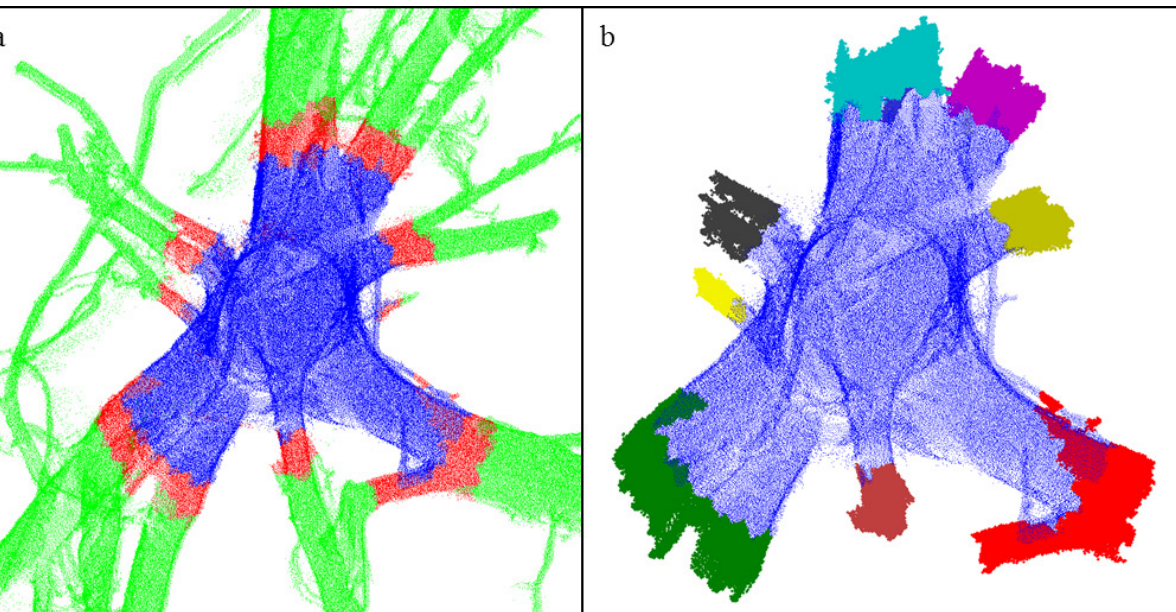
Figure 6. Determination of bases of the roots originating from the stump: ( a ) The layer B (red) between the stump (blue) and the rest of the roots (green) forms the bases of the roots; ( b ) Different colors show the final determined root bases. Notice that some small parts of layer B are not included in the root